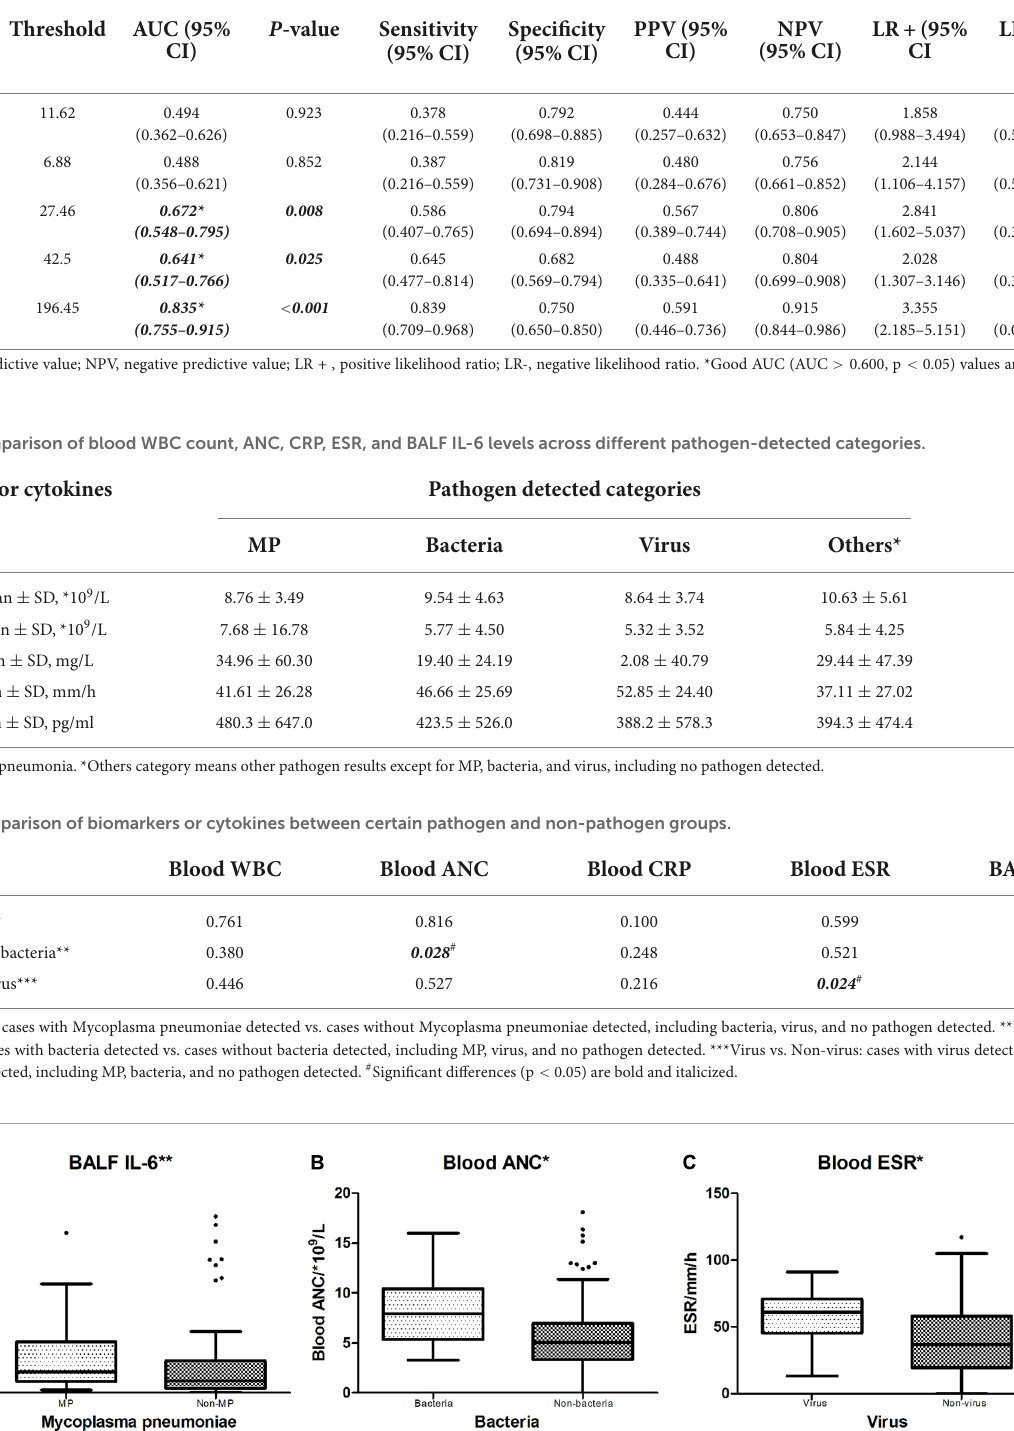
TABLE 3 Performance characteristics of biomarkers or cytokines in blood/BALF to predict moderate and severe vs. mild cases with CAP.